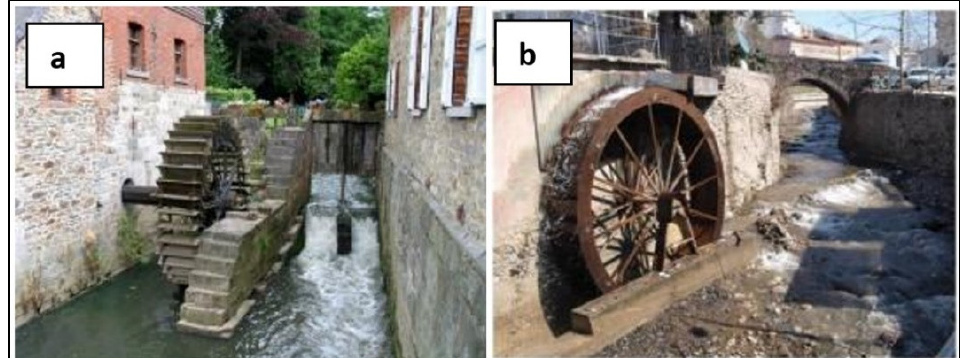
Figure 4. Early water mills: ( a ) in Braine-le-Château, Belgium, and ( b ) in Niksar, Turkey (photos by A.N. Angelakis). A.N. Angelakis).